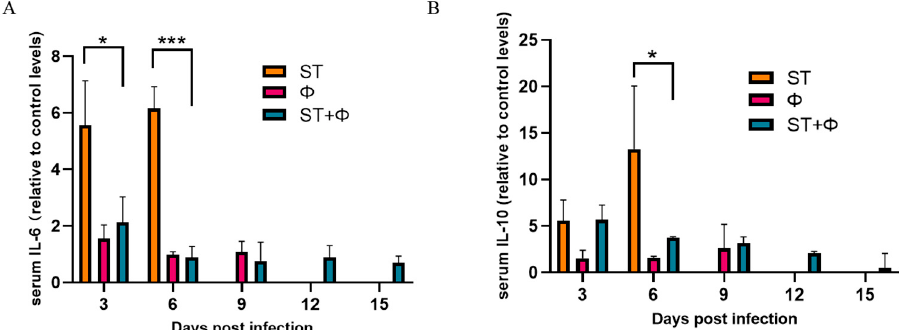
Figure 6. Phage therapy effect on inflammatory responses. ( A ) Serum levels of IL-6 on day 3 and day 6 post-infection relative to the level of IL-6 in the control group. ( B ) Serum levels of IL-10 on day 3 and day 6 post-infection relative to the level of IL-10 in the control group. *, p < 0.05 (ordinary one-way ANOVA), ***, p < 0.001.